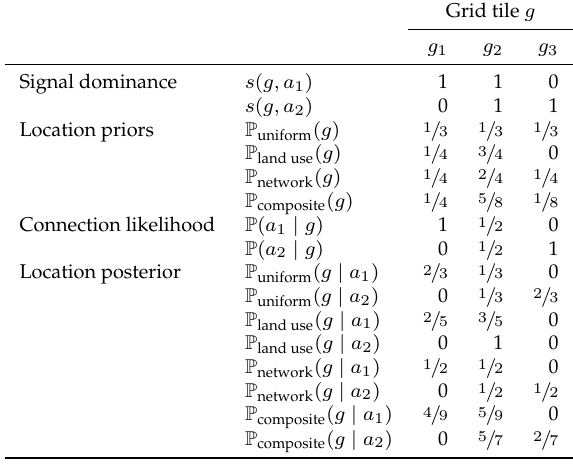
Grid tile g g 1 g 2 g 3